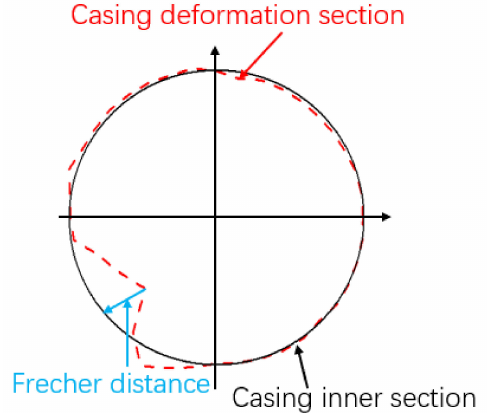
Figure 5. A schematic of the Fr é chet distance between the initial casing section and concave casing section.